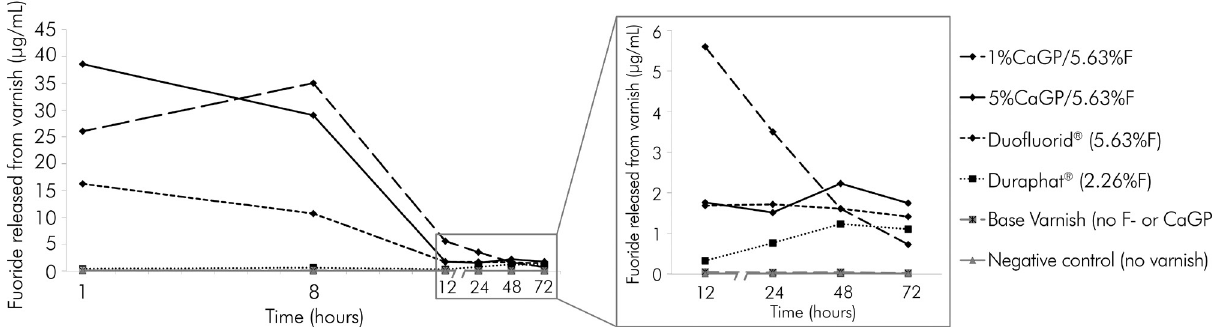
Figure 1. The amount of fluoride released from each varnish throughout the 72 hours of the